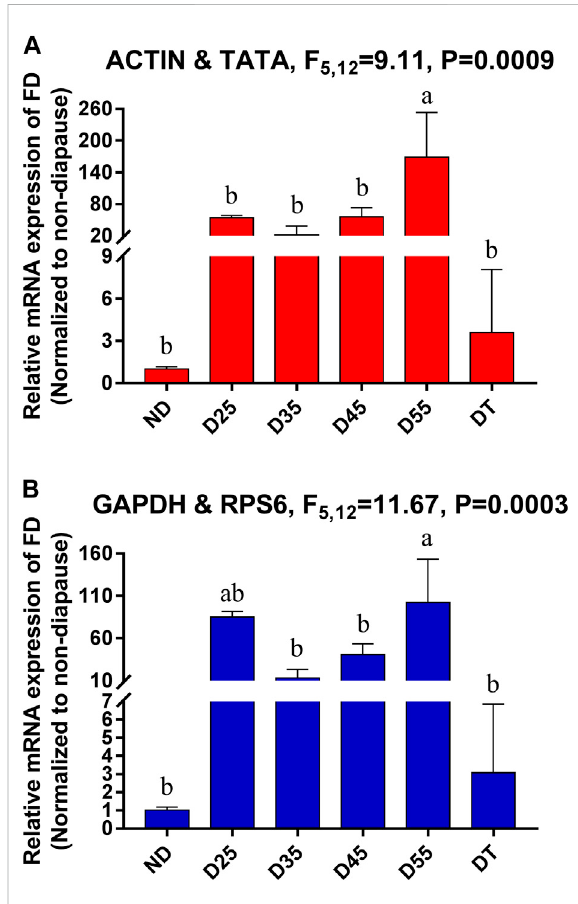
FIGURE 5 Relative gene expression of FD in different tissues of A. japonicus . The relative abundance of FD in the ND, D25, D35, D45, D55 and DT were normalized to the best stable (A, ACTIN and TATA )and least stable (B, GAPDH and RPS6 ) reference genes, respectively. ND, non-diapause mature larvae; D25, D35, D45, D55, diapausing mature larvae which incubated in diapause- inducing conditions for 25, 35, 45, 55 days; DT, diapause termination mature larvae. The values are means + SE. Different letters indicate signi fi cant differences in gene expression among different tissues of A. japonicus ( p <